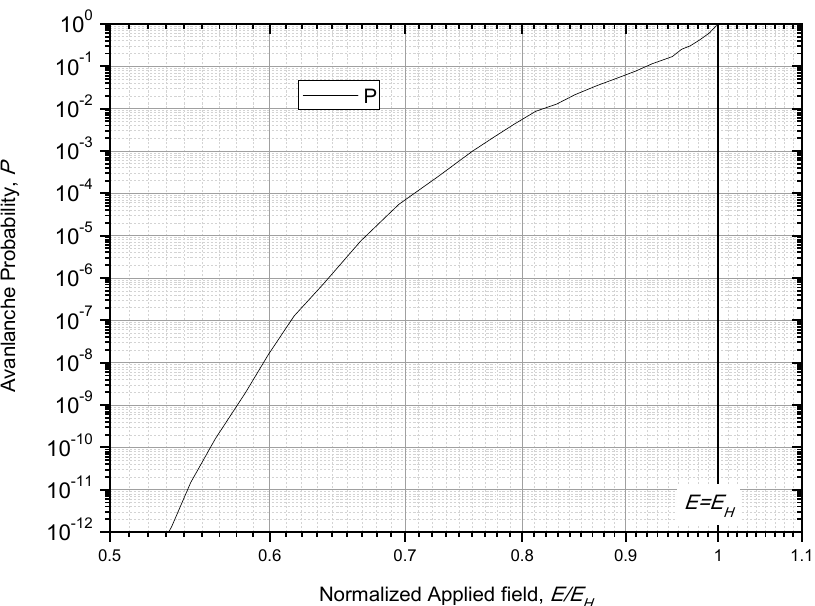
Figure 10. The dependency of avalanche formation probability P on the normalized applied field E/E H [40,41].